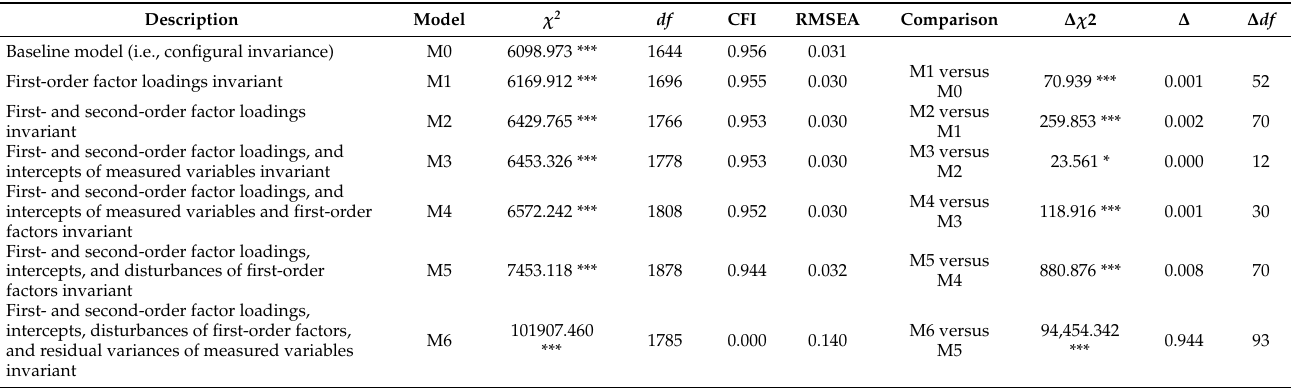
Table 7. Goodness-of-Fit Indices for Factorial Invariance of Second-Order Factor Model of Chinese Family Resilience Scale across Family Members